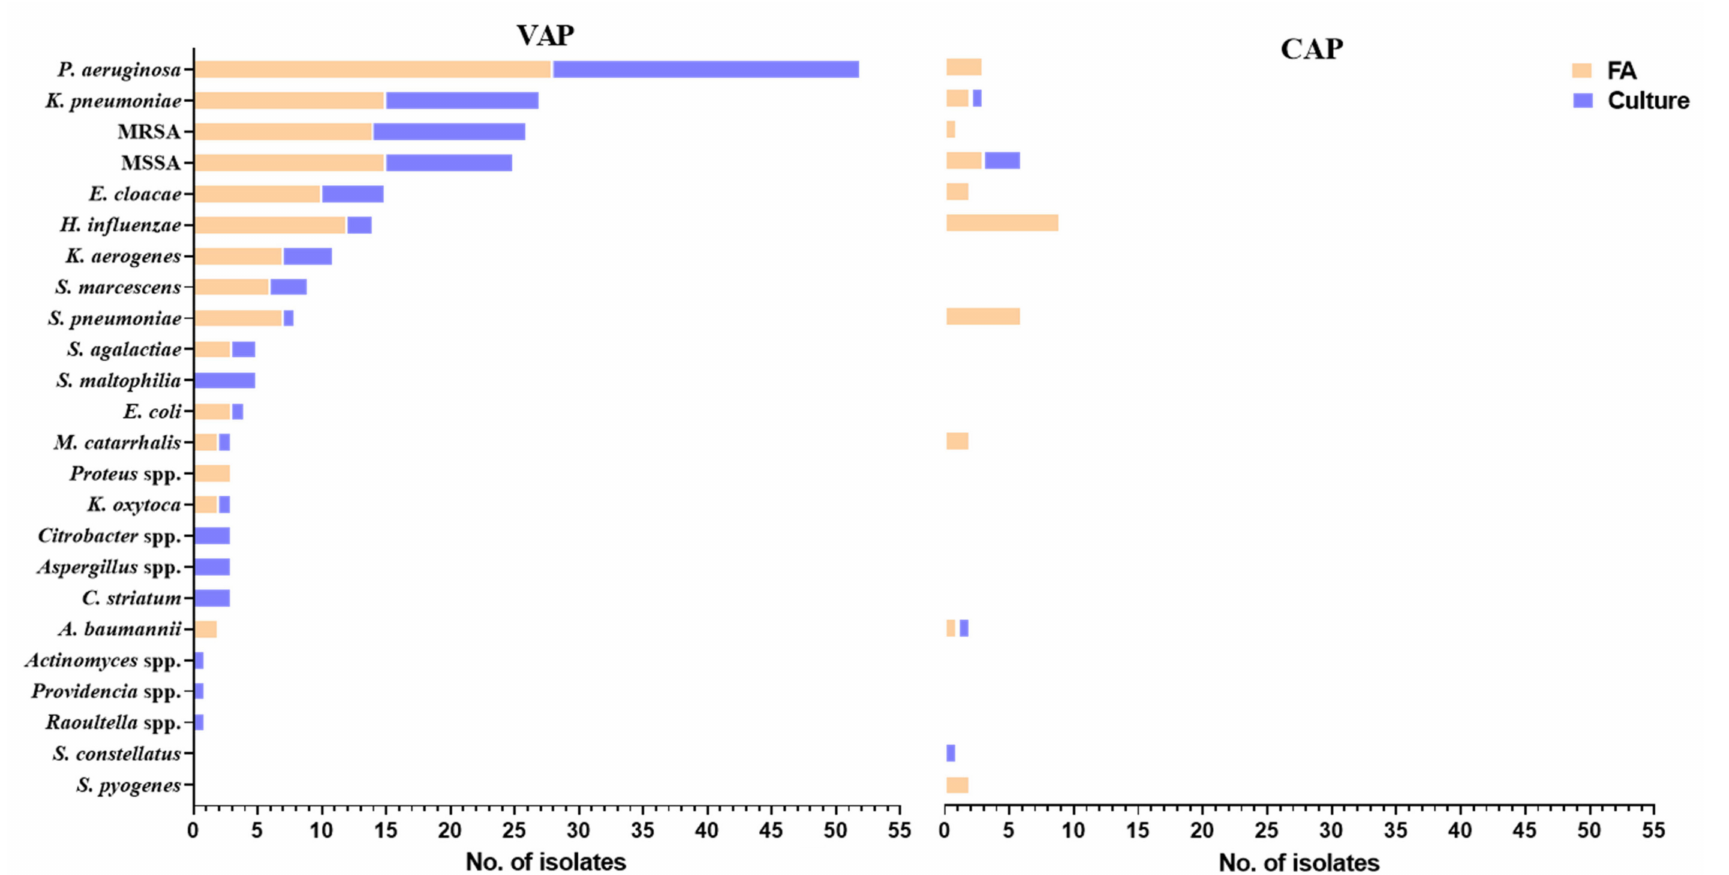
Figure 1. Absolute number of isolates identified by FA and standard cultures, in patients with CAP and